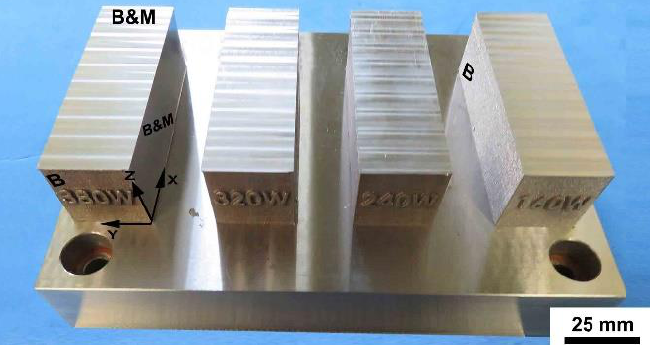
Figure 3. Prismatic blocks produced by A/SM, showing the as-built (B) and built-and-machined (B&M) faces.